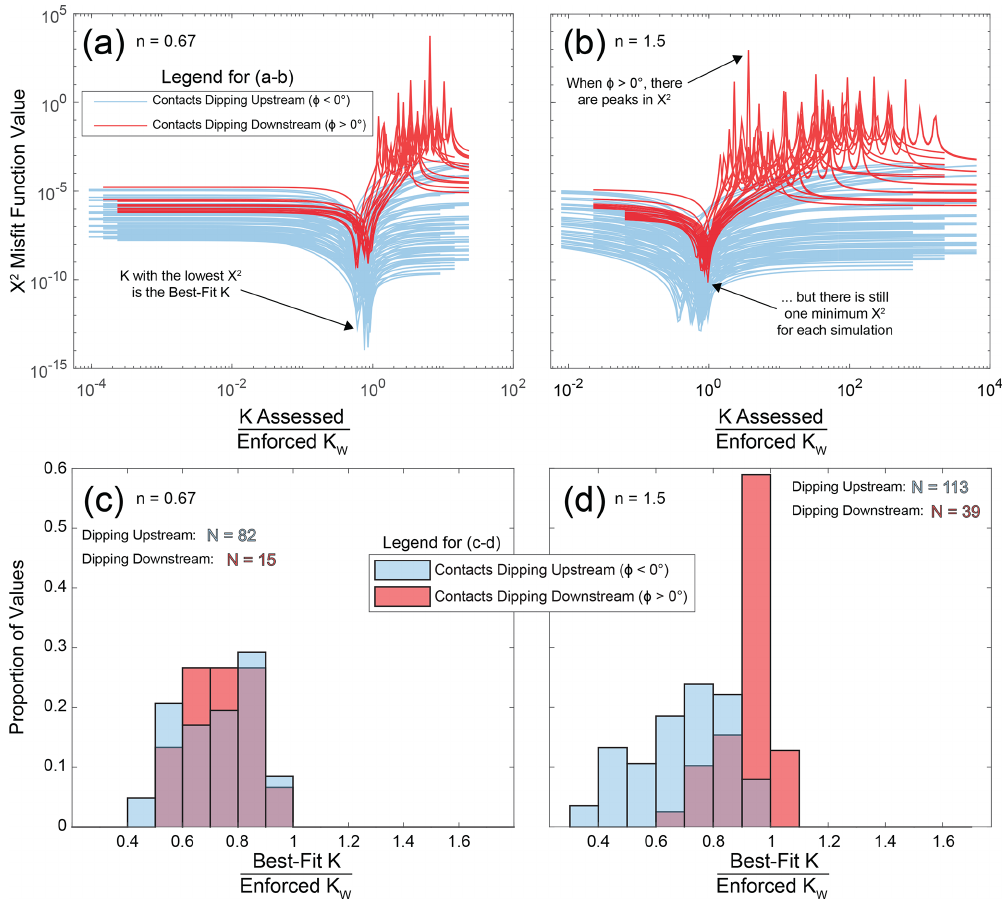
Figure 12. Comparison of best-fit K values in our numerical models to the weak erodibility ( K W ) used in each simulation. (a, b) X 2 mis- fit function values for kinematic wave speeds ( C H ) estimated using Eq. (12), the enforced contact dip ( φ ), and a wide range of K values (200 points spaced logarithmically from 10 − 9 to 10 − 4 m 1 − 2 nθ yr − 1 , where θ = 0 . 5) relative to the Eq. (13) estimates of C H . (c, d) Com- parison between the best-fit K and the K W enforced in the simulations. Panels (a) and (c) show results for n = 0 . 67, while panels (b) and (d) show results for n = 1 .